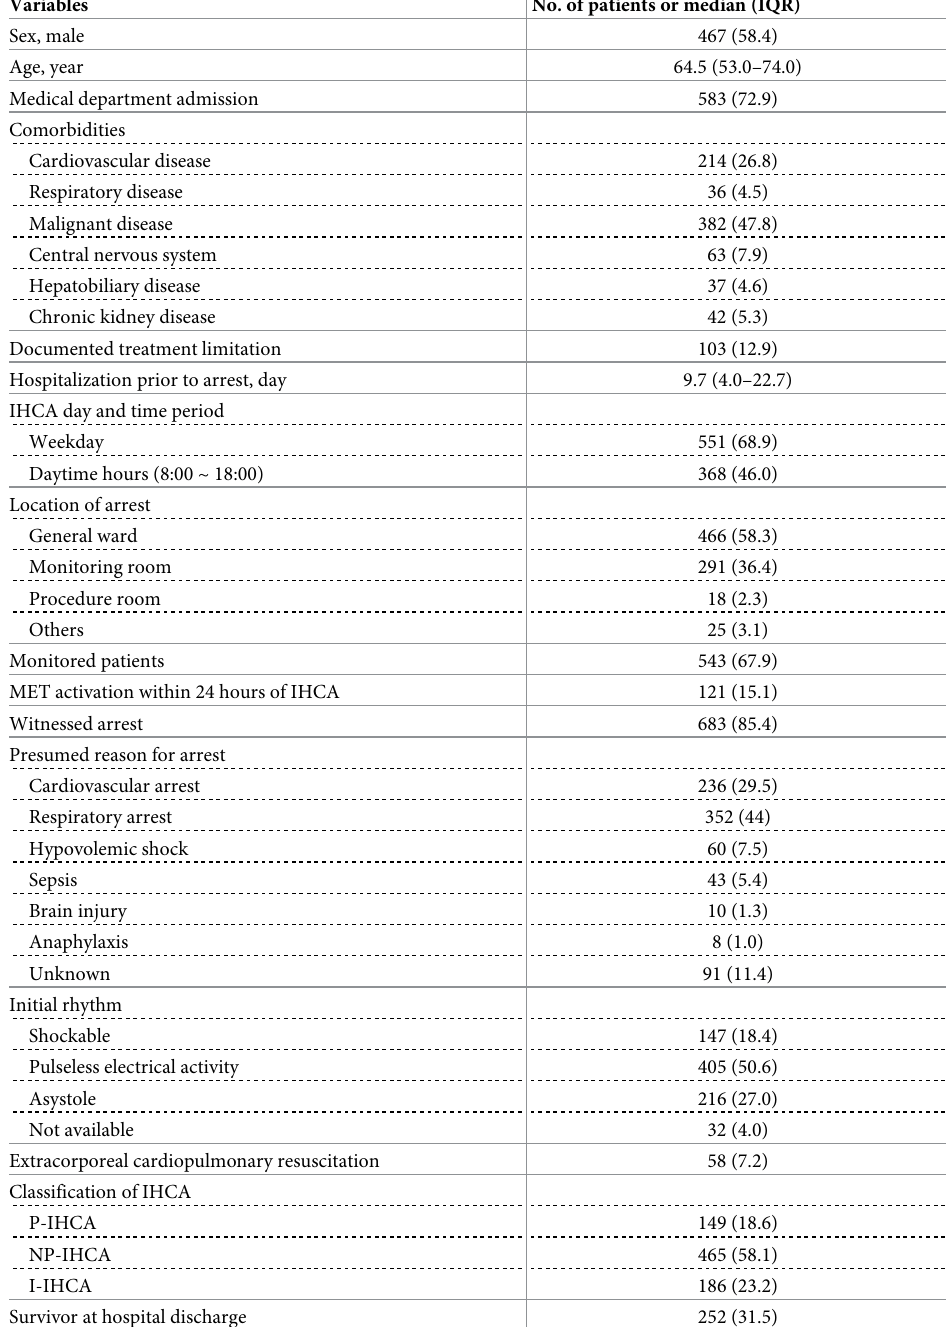
Table 2. Clinical characteristics of in-hospital cardiac arrests (N =